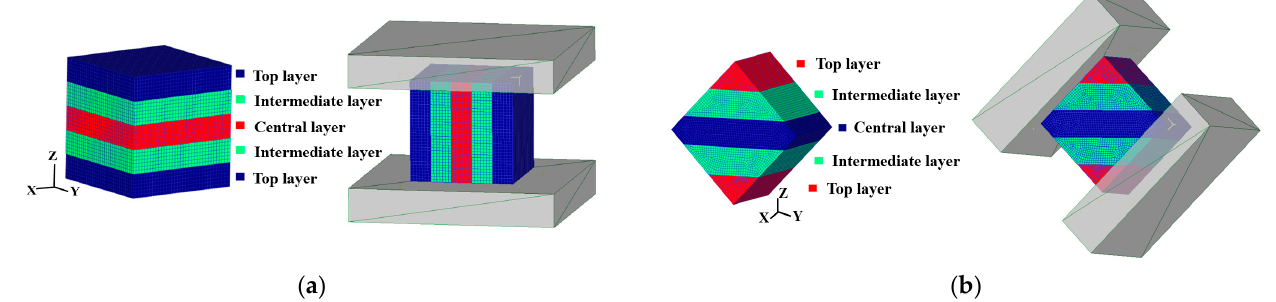
Figure 9. FE model of cube specimens considering plastic anisotropy: ( a ) 15 mm cube, ( b ) 10.6 mm cube.